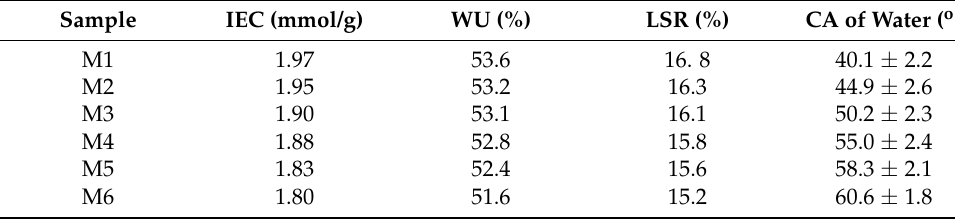
Table 1. WU, ICE, LSR, and WCA. Table 1. WU, ICE , LSR, and WCA.